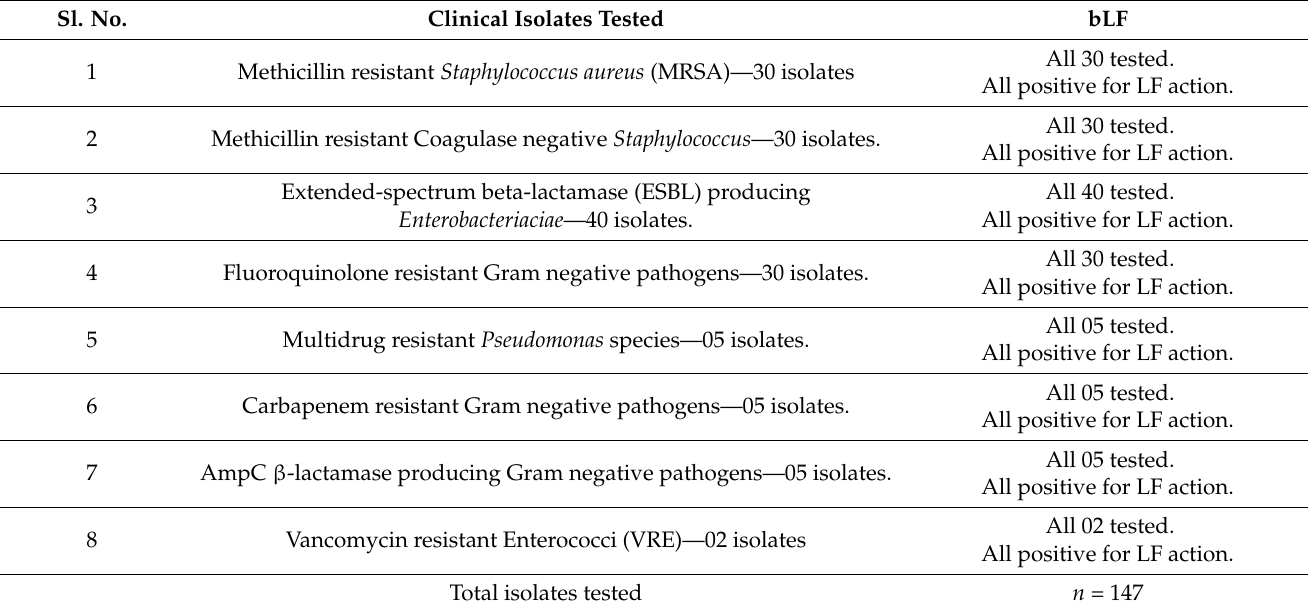
All 30 tested. All positive for LF action. All 40 tested.